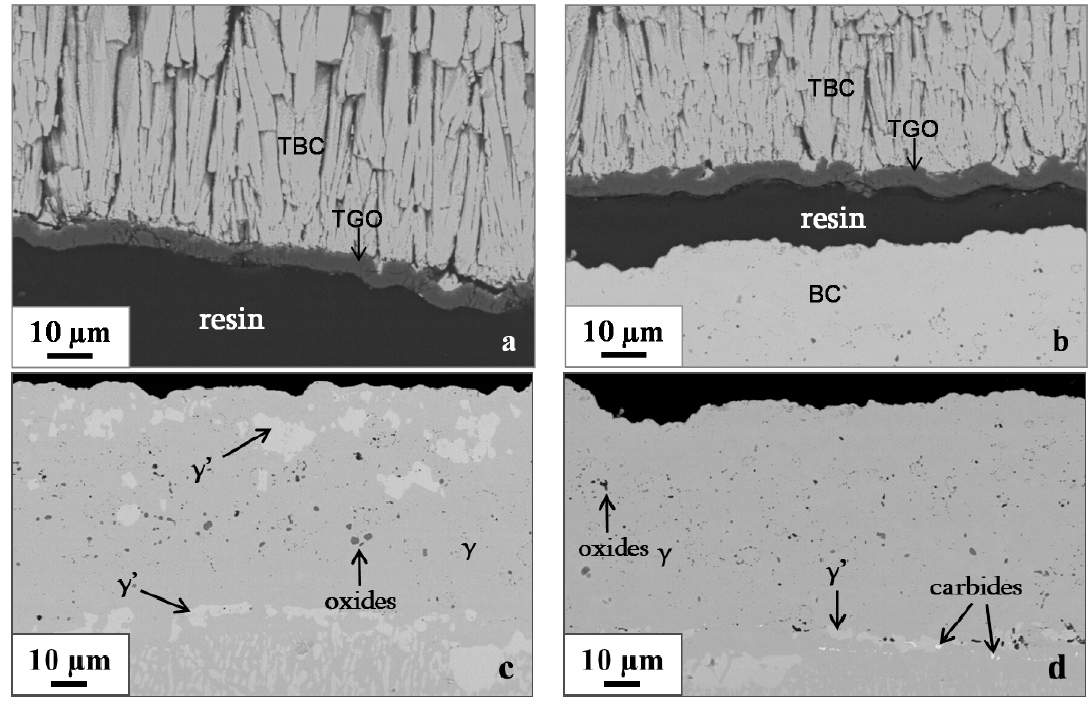
Figure 5. Cross-sections of ( a , c ) AM3-Trib-Pt/2 TBC system; and ( b , d ) MCNG-Trib-Pt/2 TBC system after 300 cycles. Thermal cycles of 1 h at 1100 °C, with a high-flow air cooling. SEM images in BSE mode.